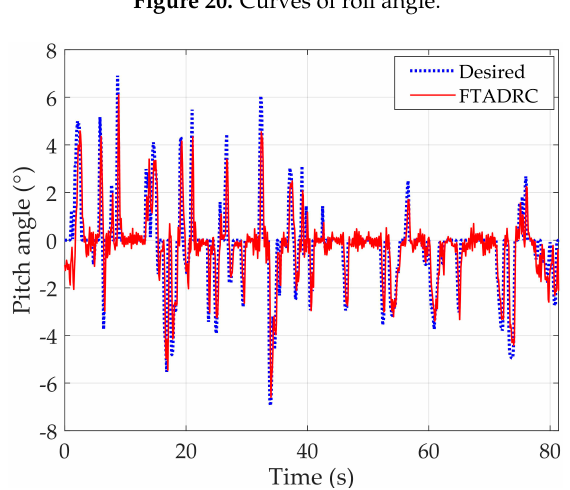
Figure 21 . Curves of pitch angle.